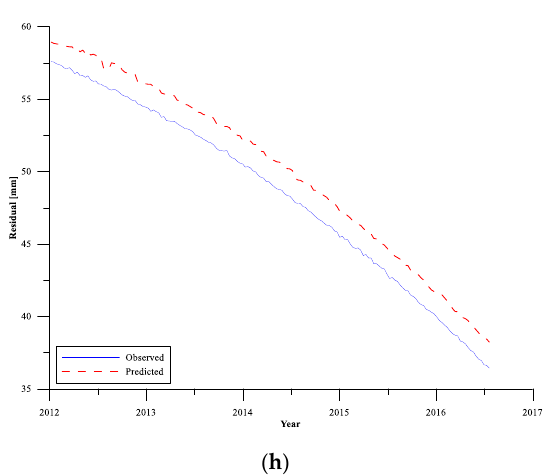
Figure 5. Comparison of predictions of IMF components by CEEMD decomposition for testing period with optimal RBF network (Panels ( a – g ) represent the IMFs with cycles respectively, Panel ( h ) represents the residual.).